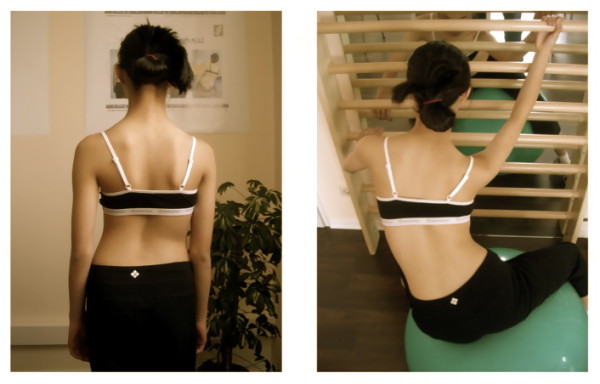
Corrective movement during a ‘Power Schroth’ exercise. (With kind permission by Pflaum, Munich).